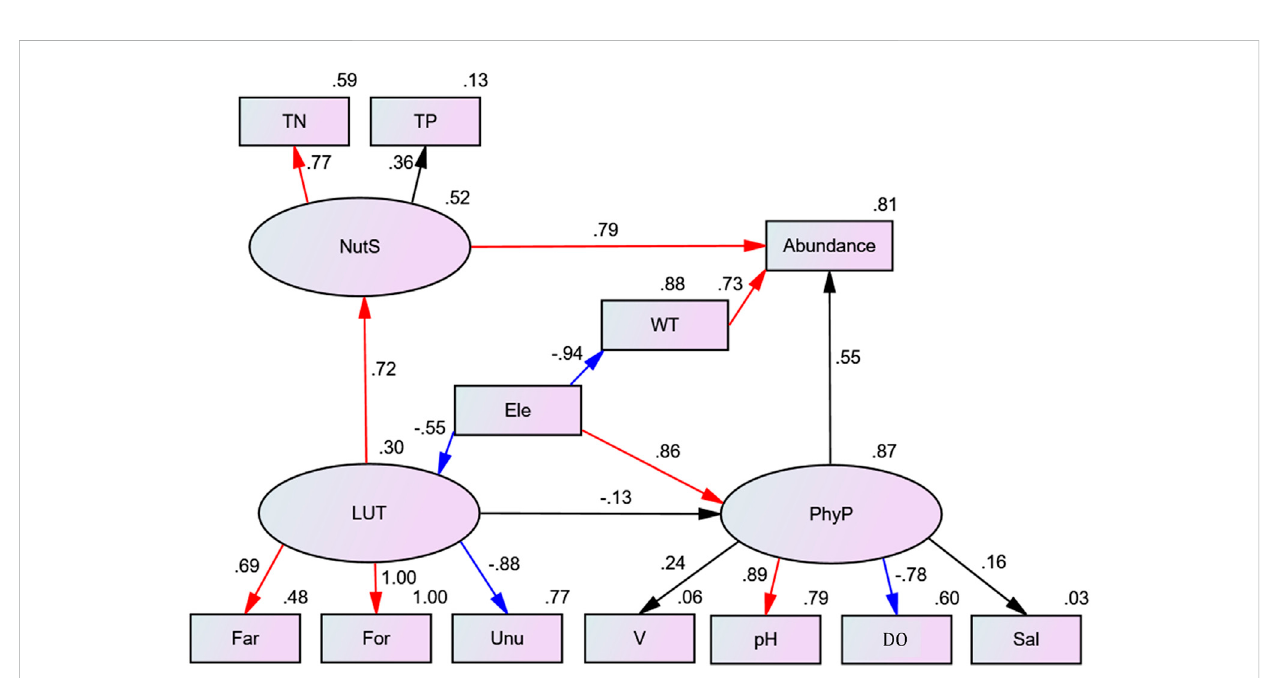
FIGURE 8 Structural equation model of interaction between environmental variables and phytoplankton